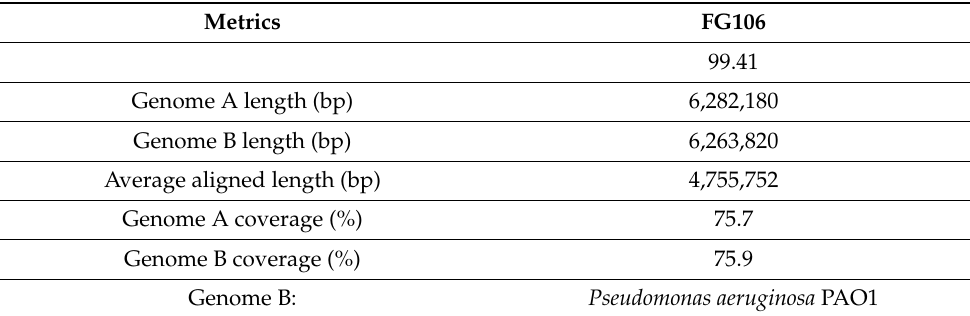
Table 10. Average amino acid identity (AAI) data for the FG106 genome. Average Amino Acid Identity